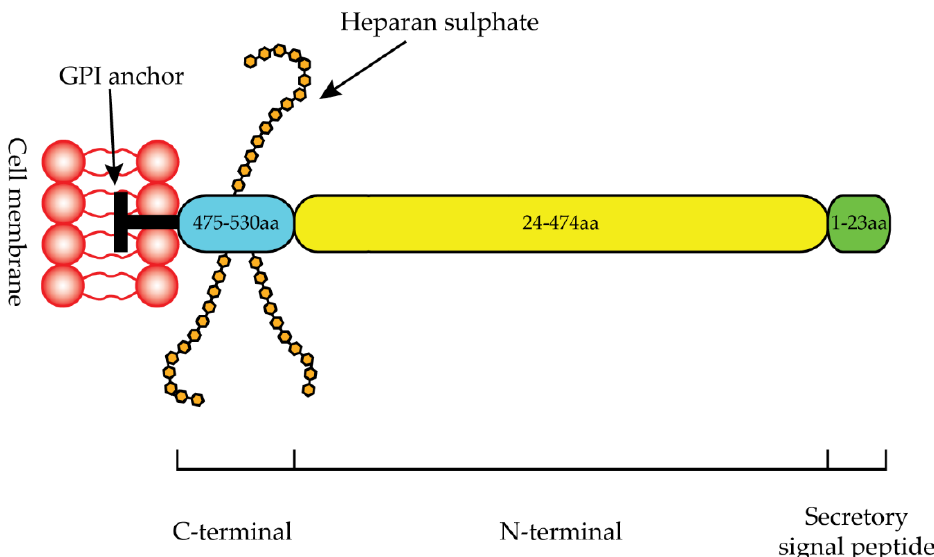
Figure 3. schematic representation of GPC1 protein. Figure 3. Schematic representation of GPC1